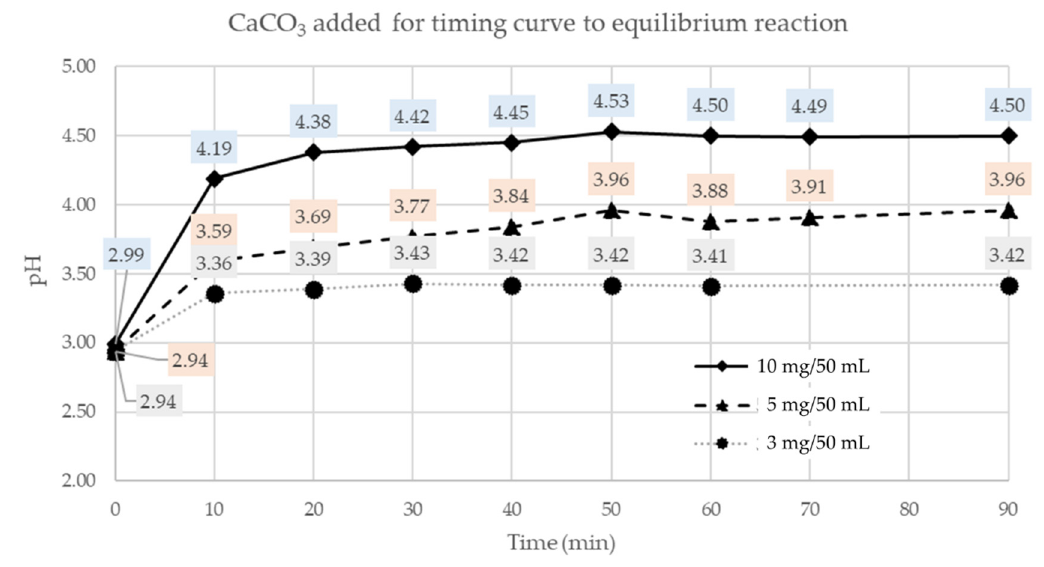
Figure 2. Result of reaction time to obtain the equilibrium, between samples and buffering carbonate added. After one hour, the pH value has stabilized.